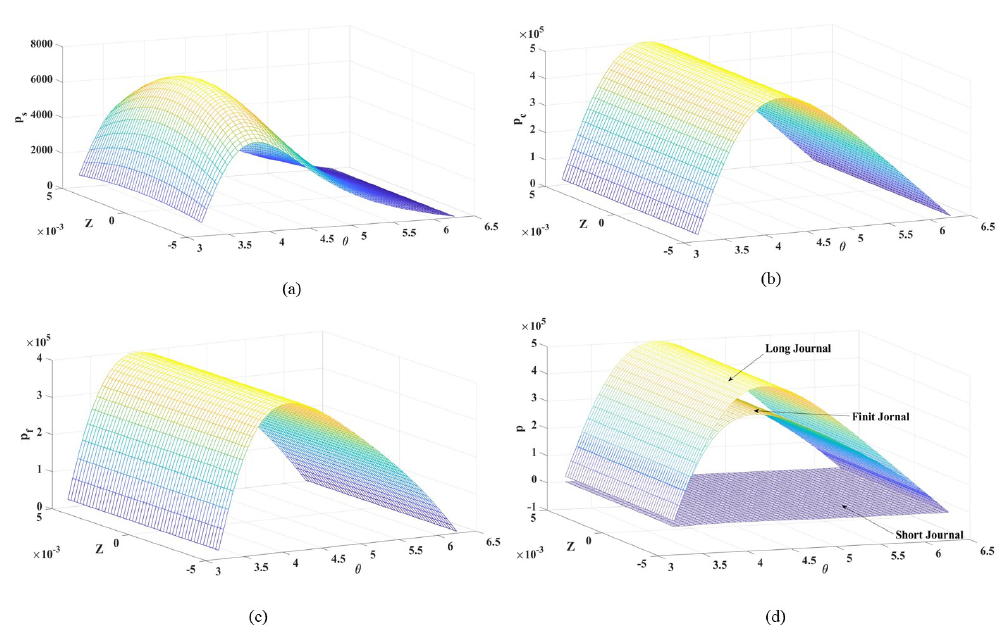
Figure 7. Graph of the oil film pressure under three approximation theories. ( a ) Short bearing. ( b ) Long bearing. ( c ) Finite length bearing. ( d ) Three approximation